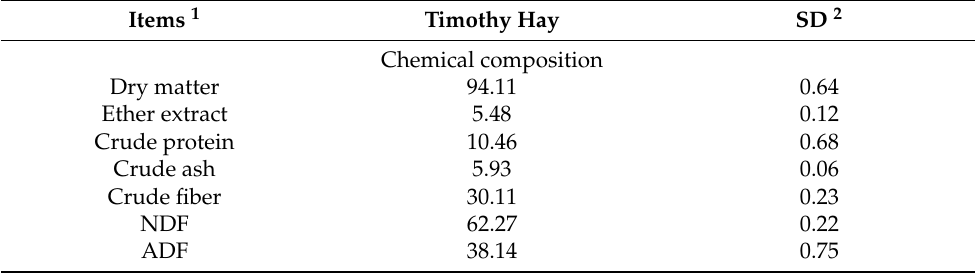
Table 1. Chemical composition of control diet (dry matter basis,